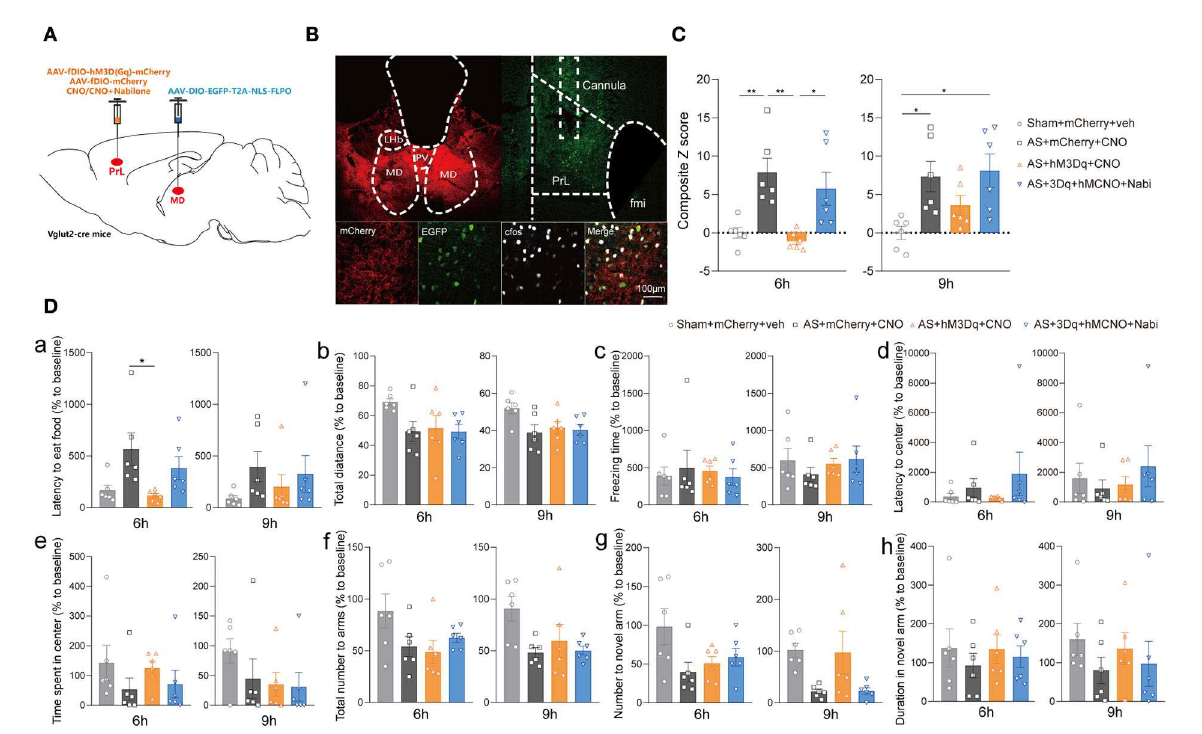
FIGURE6 The MD glu -PrL glu circuit was involved in the effect of eCB on POD. (A) Scheme of viral injection and CNO application. (B) The injection site in MD and PrL (above) and activation efficiency (below). (C) The composite Z score at 6h (left) and 9h (right) after AS. (D) The latency to eat food in buried food test (a); the total distance (b), the freezing time (c), the latency to center (d), time spent in center (e) in the open field; the total number to arm (f), number to novel arm (g), duration in the novel arm (h) in Y maze at 6h (left) and 9h (right) after AS. Data are shown as mean ± SEM. N = 6. * P < 0.05, ** P < 0.01. AS, anesthesia and surgery; Nabi, nabilone; CNO, clozapine N-oxide; mCherry, AAV-fDIO-mCherry; hM3Dq, AAV-fDIO-hM3Dq-mCherry; PrL, prelimbic cortex; MD, mediodorsal